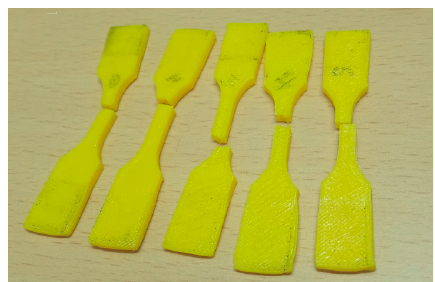
Figure 4: Common fabricated samples after the tensile test.